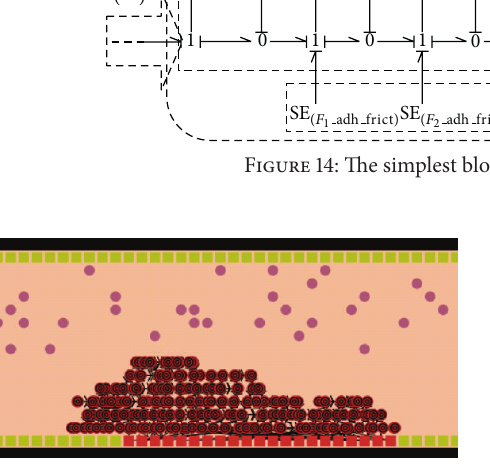
Figure 15: ABS blood clot model (200 agents).